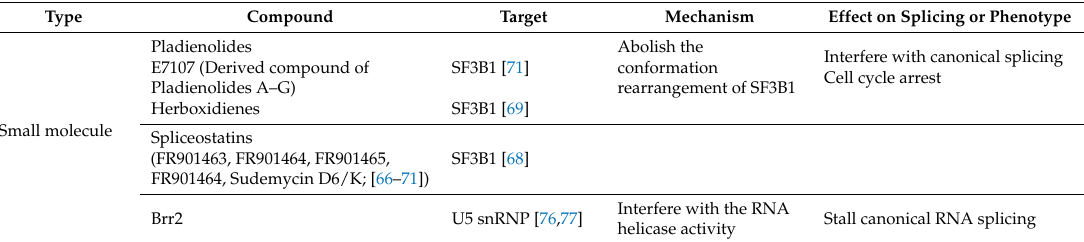
Table 2. Small compounds and oligonucleotides documented to alter splicing